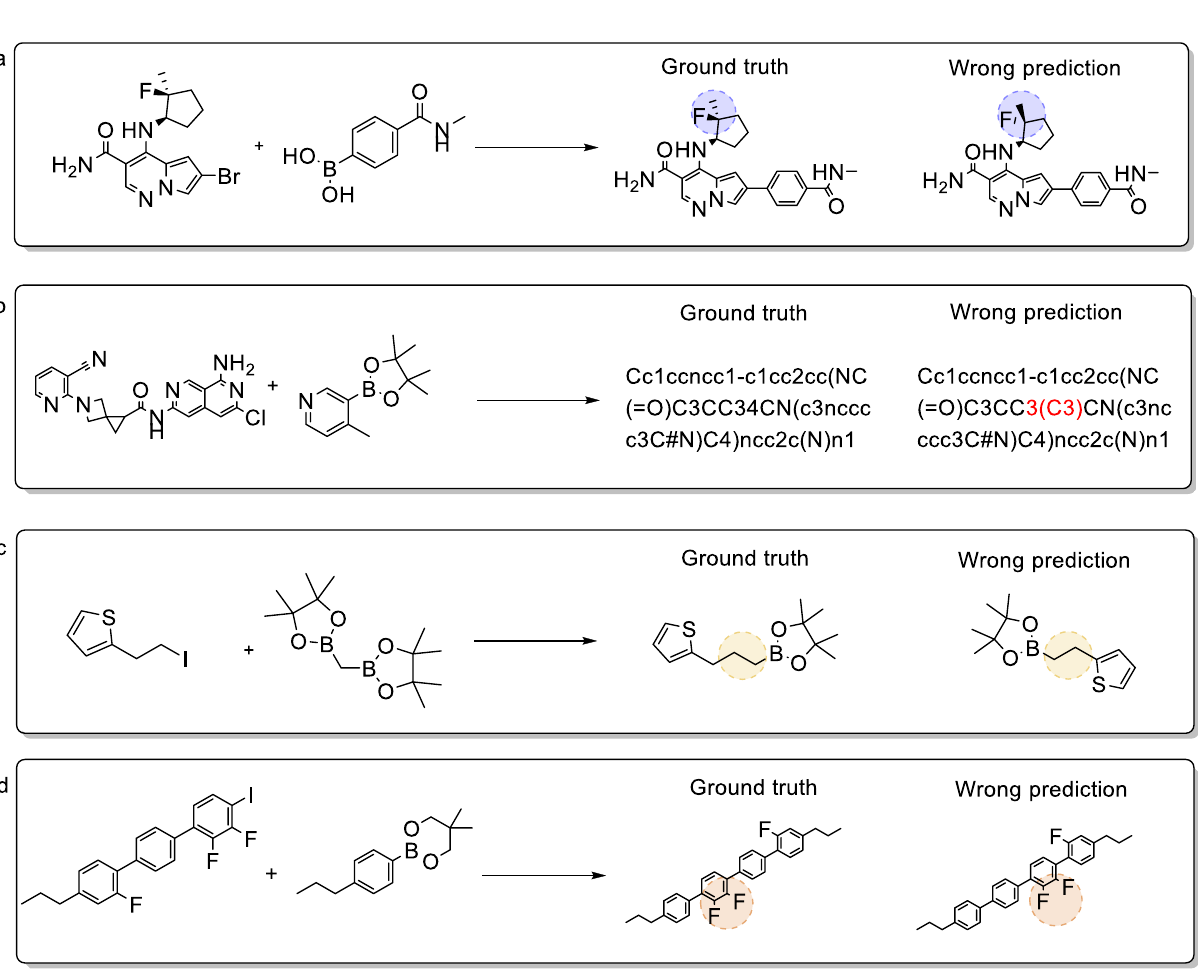
Figure 6. Typical error analysis of Suzuki coupling reactions. ( a ) Chirality errors, ( b ) SMILES errors, ( c ) the number of atom errors, ( d ) functional group isomerism